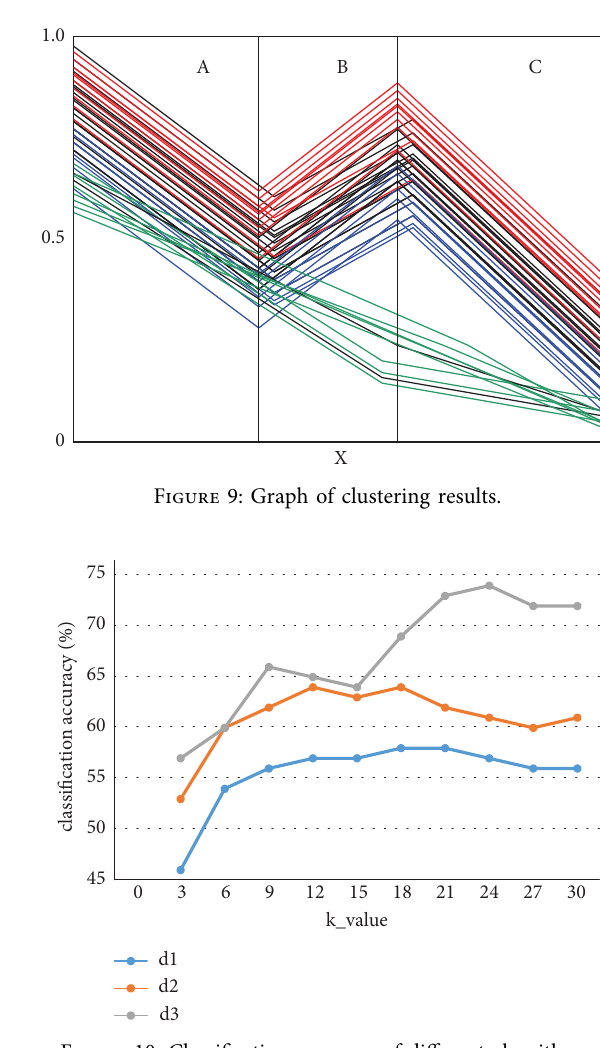
Figure 10: Classifcation accuracy of diferent